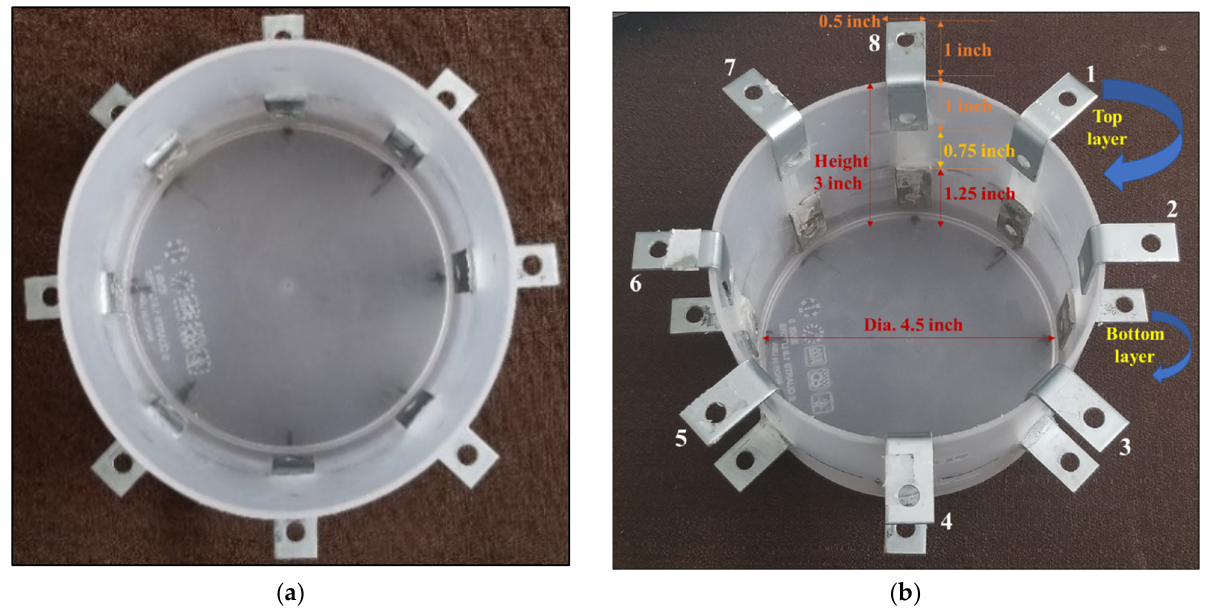
Figure 1. An electrode array sensor with ( a ) 8 electrodes (bottom layer) for 2D EIT, and ( b ) 16 electrodes (top and bottom layers) designed in a cylindrical domain for 3D EIT